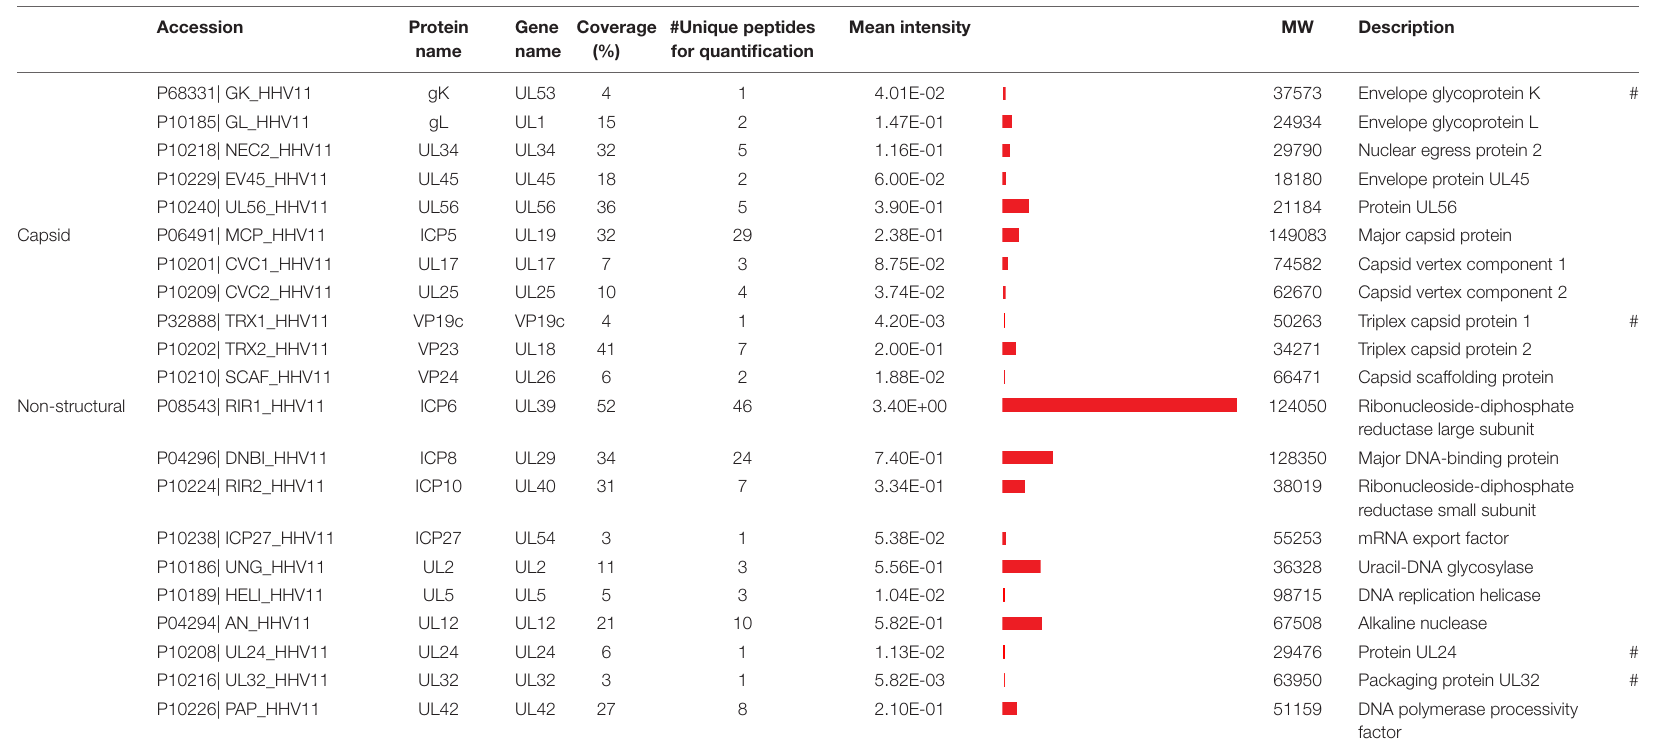
2.10E-01 51159 DNA polymerase processivity factor L-particles were purified from supernatants of HSV − 1-infected mDCs cells using a Ficoll gradient. Subsequently, samples were prepared for mass spectrometric analyses. Proteins are summarized regarding their predicted localization in the viral particle in numerical order and mean intensities of all three replicates are normalized to mean of all glycoproteins detected in at least two out of three samples. “MW” means molecular weight. Proteins detected in two out of three samples are marked with